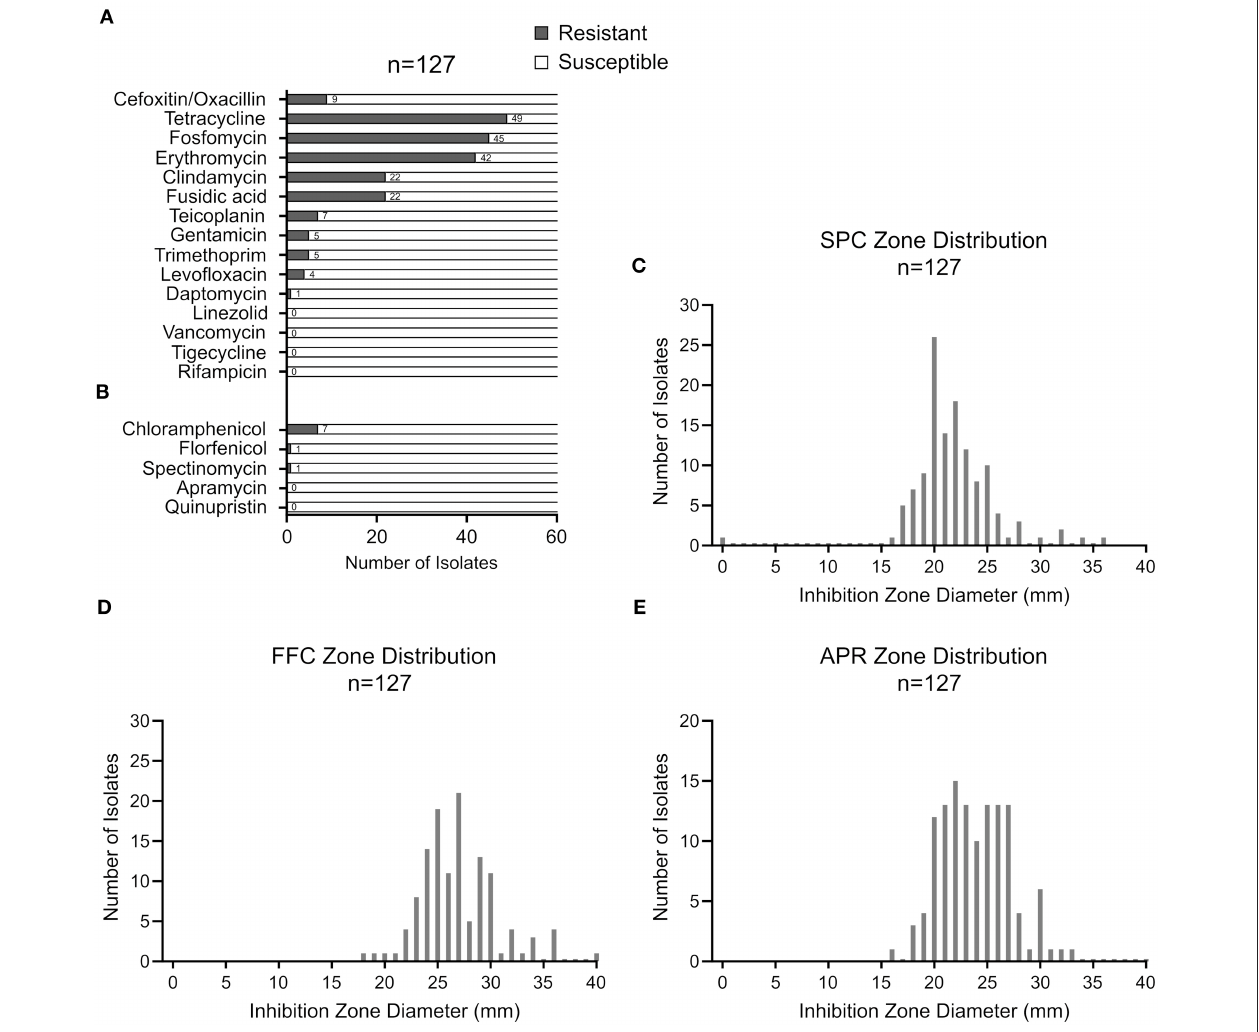
FIGURE 2 | CoNS resistance profiles assessed by VITEK2 (A) or by agar disk diffusion (B) . Inhibition zone diameter distributions for spectinomycin (C) , florfenicol (D) and apramycin (E) with 100, 30, and 15 µ g of the respective antimicrobial agent, respectively, according to EUCAST guidelines.